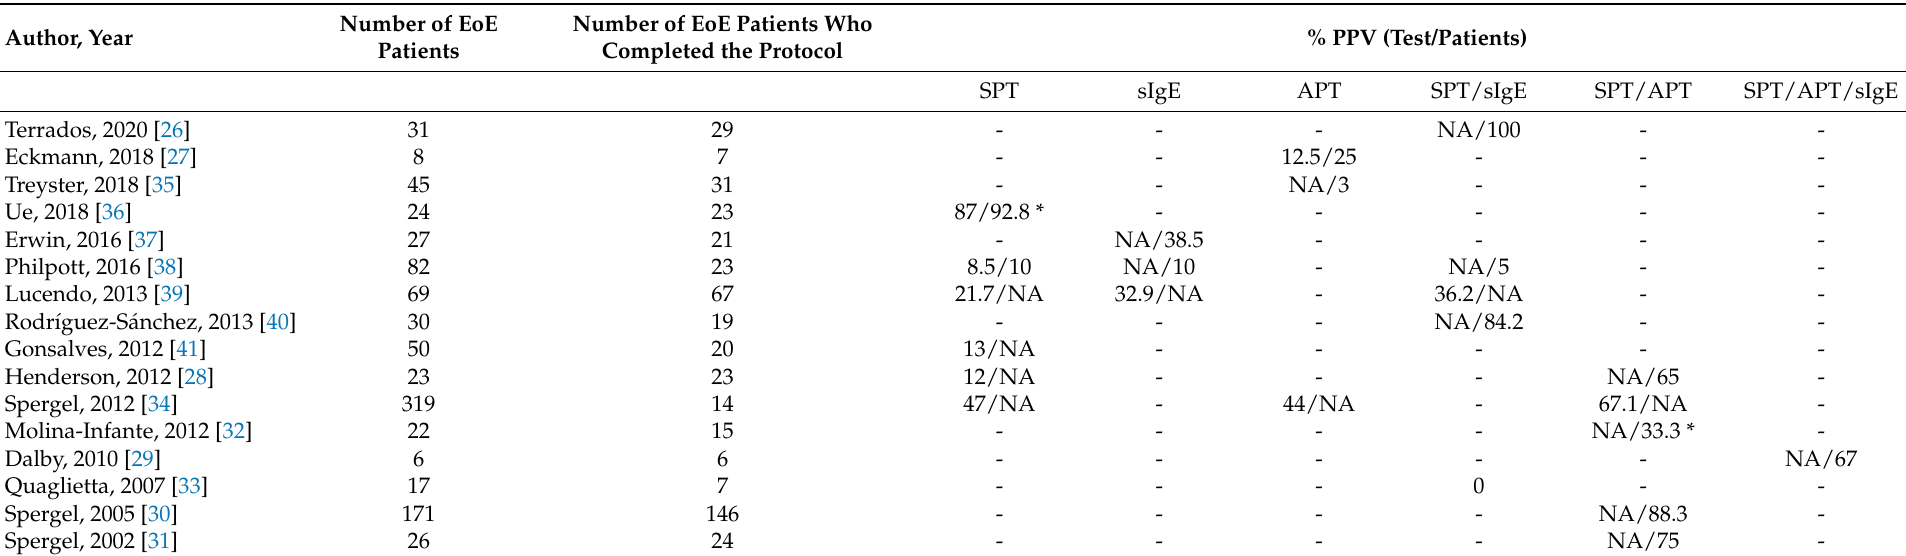
Table 3. Positive predictive value of allergy